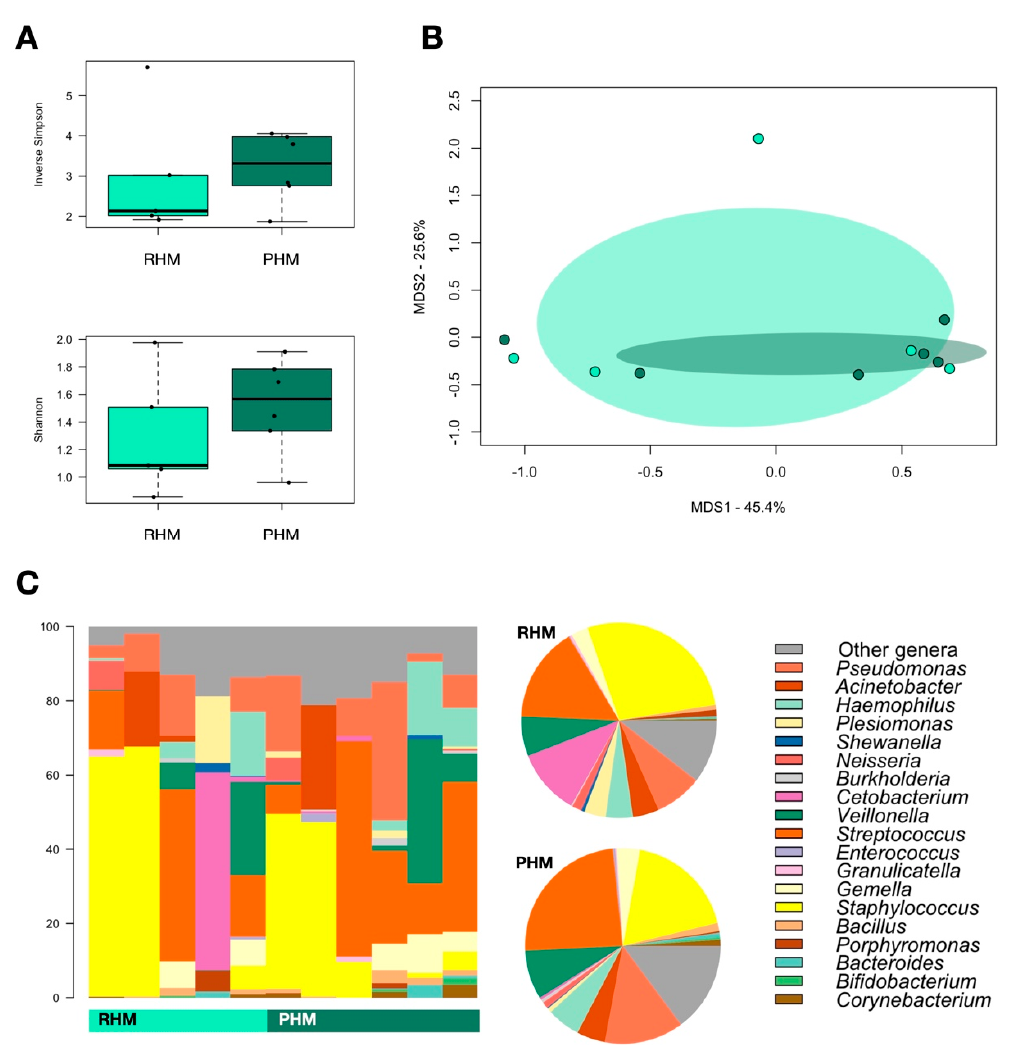
Figure 2. The impacts of pasteurization on donor human milk microbiota. ( A ) Boxplots showing the distribution of alpha diversity, assessed by the inverse Simpson ( top ) and Shannon ( bottom ) indices, in donor human milk microbiota before (RHM) and after pasteurization (PHM). ( B ) Principal coordinate analysis (PCoA) of the Bray-Curtis distances between the genus-level microbial profiles of the two study groups, RHM (light green) and PHM (green). ( C ) Genus-level relative abundance profiles of RHM and PHM samples. Data are shown in the bar charts for each sample and in pie charts as mean values in the study groups.